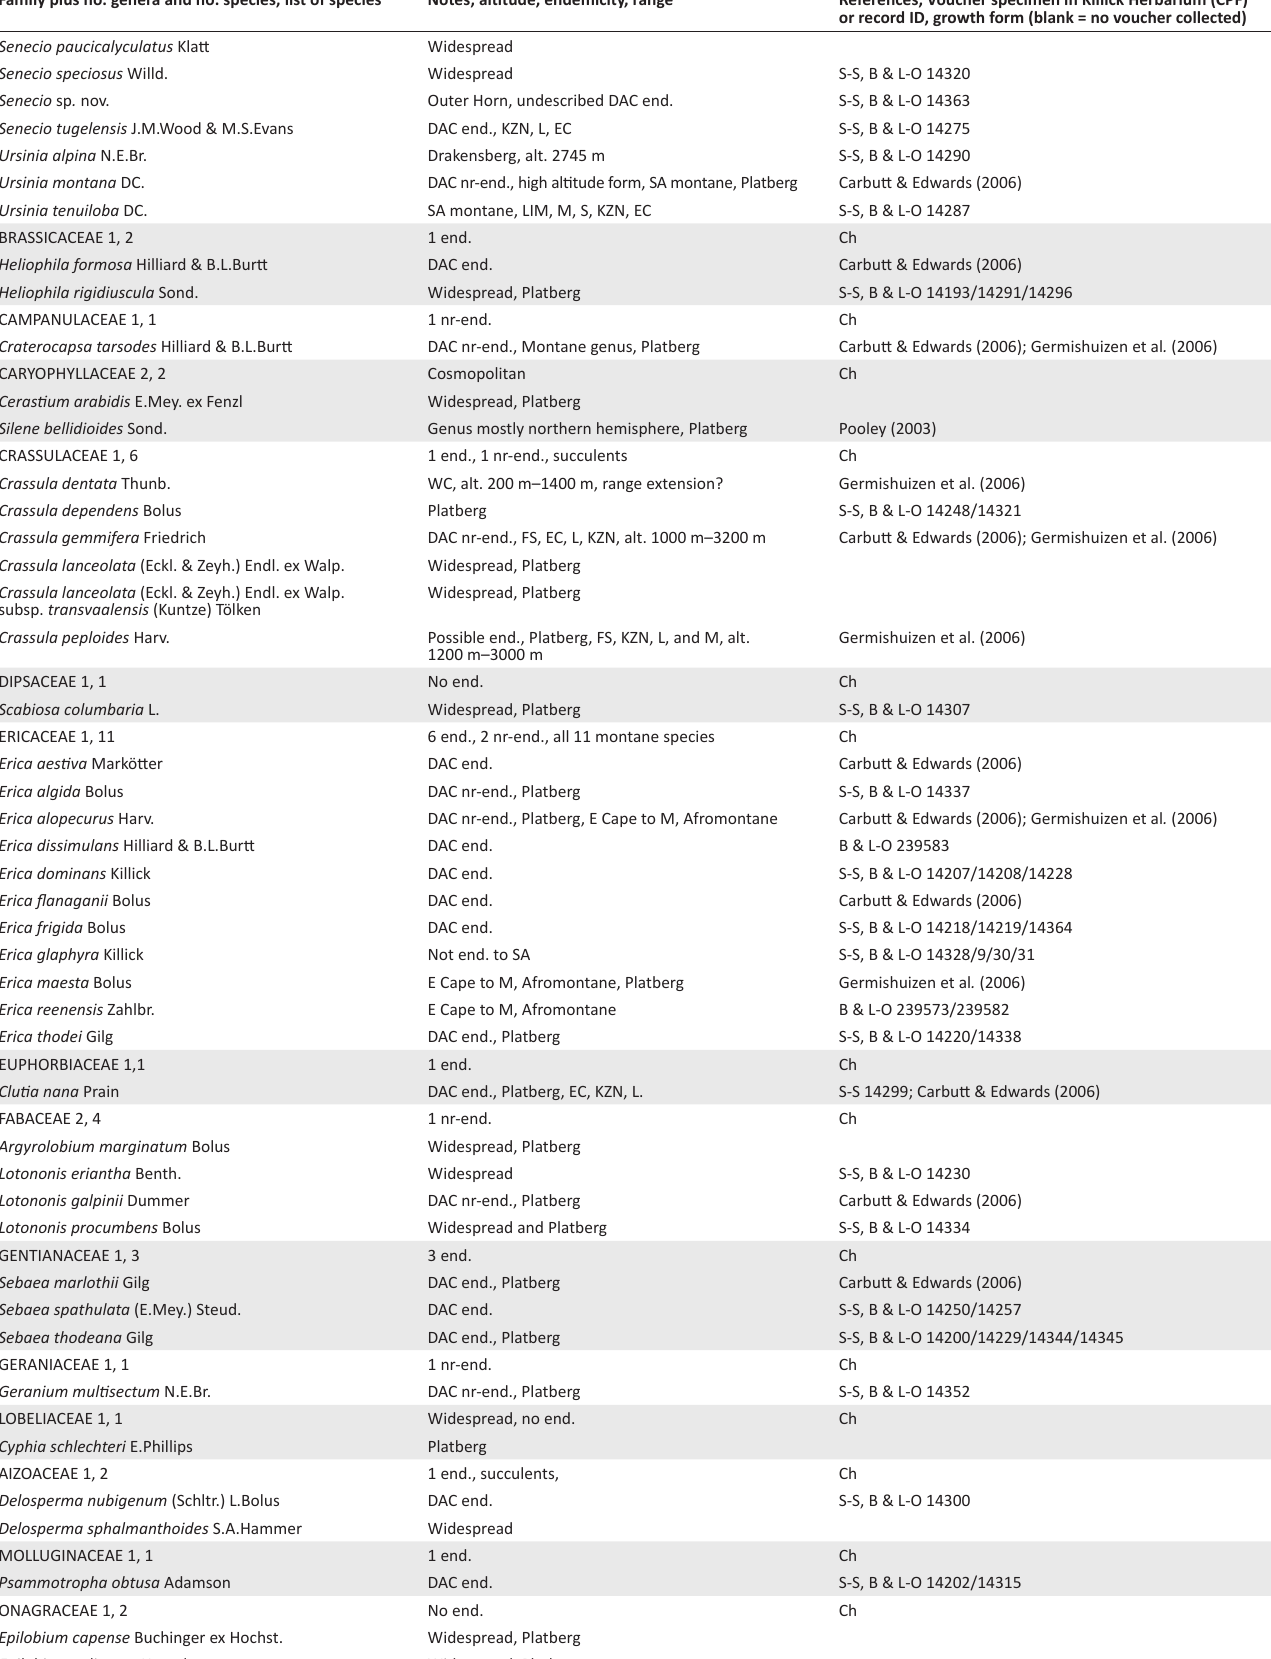
TABLE 2-A1: Angiosperms – Monocotyledons, 16 Families, 37 Genera, 66 Species, 13 endemics, 25 near endemics = 38. Family plus no. genera and no. species; list of species Notes; altitude, endemicity, range